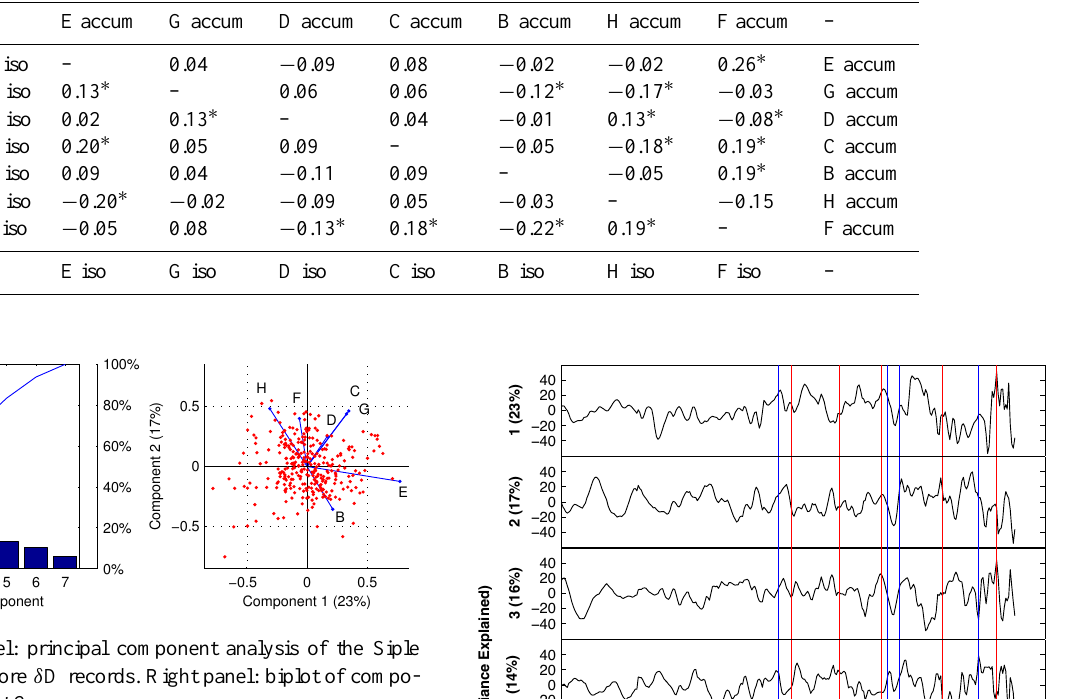
Table 1. The Siple Dome shallow ice core sites (B-H) and borehole temperature measurement sites (G, B, H, J) used in this study. Site Data Type